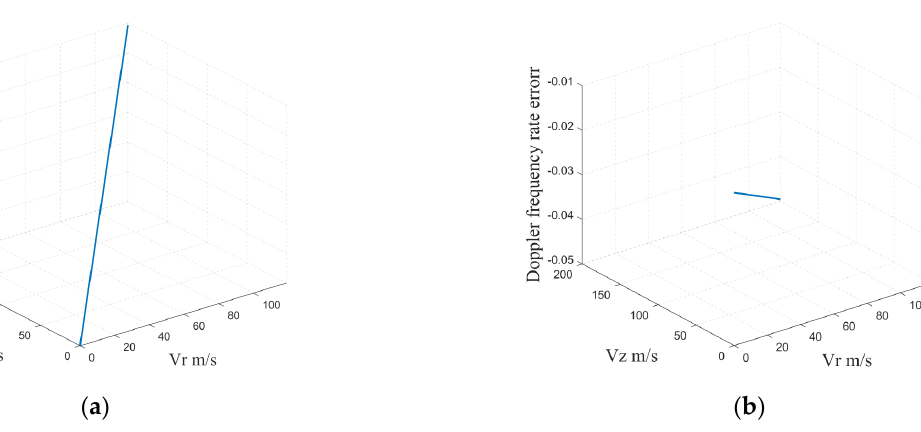
Figure 8. ( a ) Deviation of the Doppler centroid with the velocity between the 1st and 20th images; ( b ) deviation of the Doppler frequency rate with the velocity between the 1st and 20th images. Case 2: Azimuth Offset